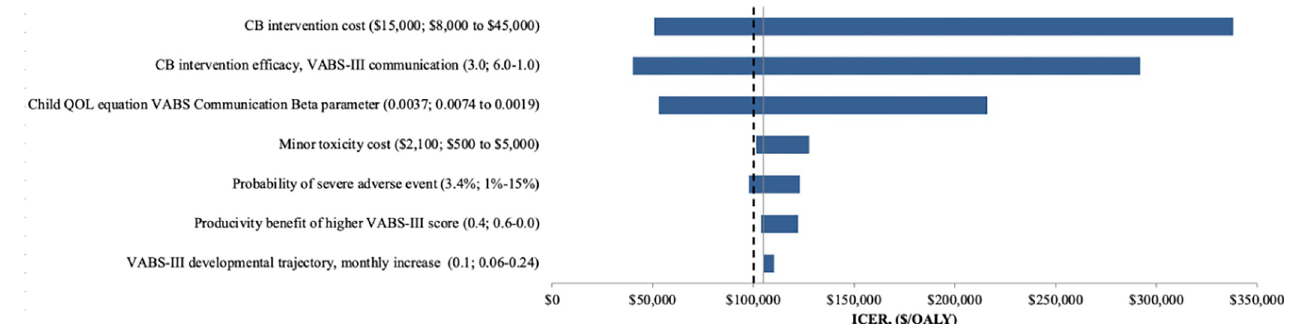
Fig 1. Tornado diagram of cost-effectiveness of one-way sensitivity analyses. This Figure shows the influence of several individual parameters, varied across their plausible ranges, on cost-effectiveness on the CB intervention. Ranges assessed are presented as (base-case value: value that yields lowest ICER—value that yields highest ICER). The four most influential parameters on cost-effectiveness results were CB cost, CB efficacy, child QOL mapping equation beta parameter, and minor toxicity cost. CB: cord blood, ICER: incremental cost-effectiveness ratio, QALY: quality-adjusted life year, QOL: quality of life, VABS-3: Vineland Adaptive Behavior